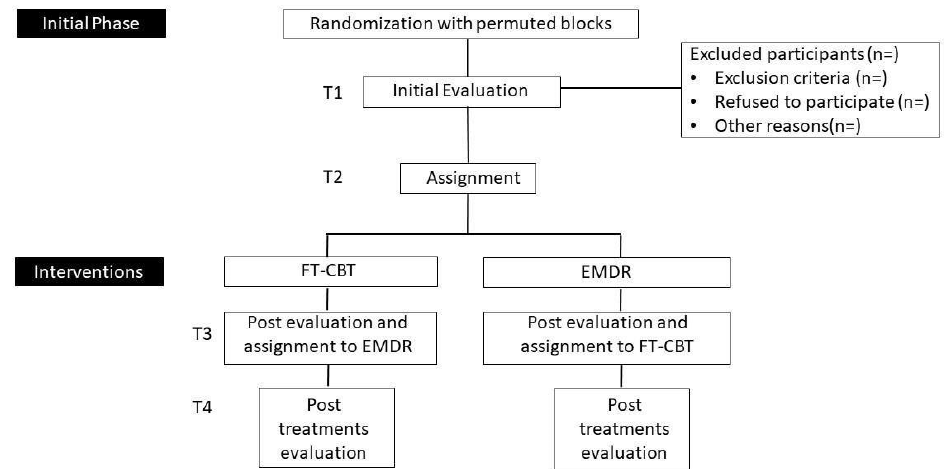
Figure 2. Study design FT-CBT and EMDR.